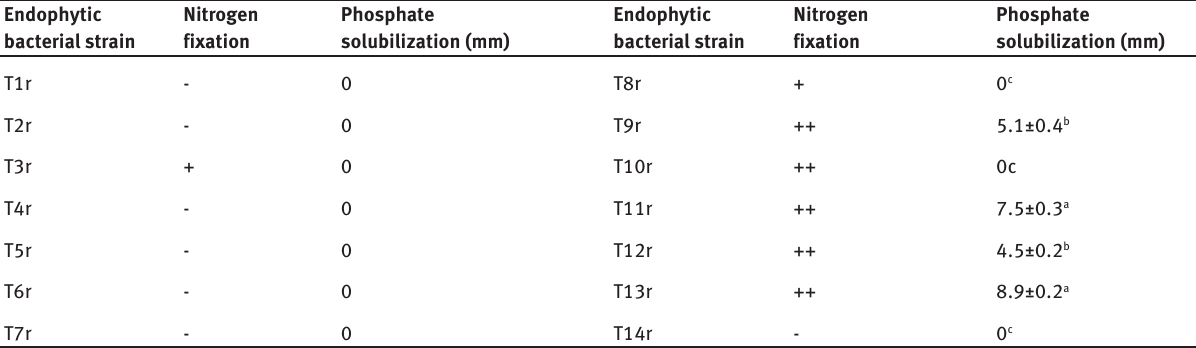
Table 2: Nitrogen fixation and phosphate solubilization activities of bacterial endophytes isolated from the root of T. vulgaris L.